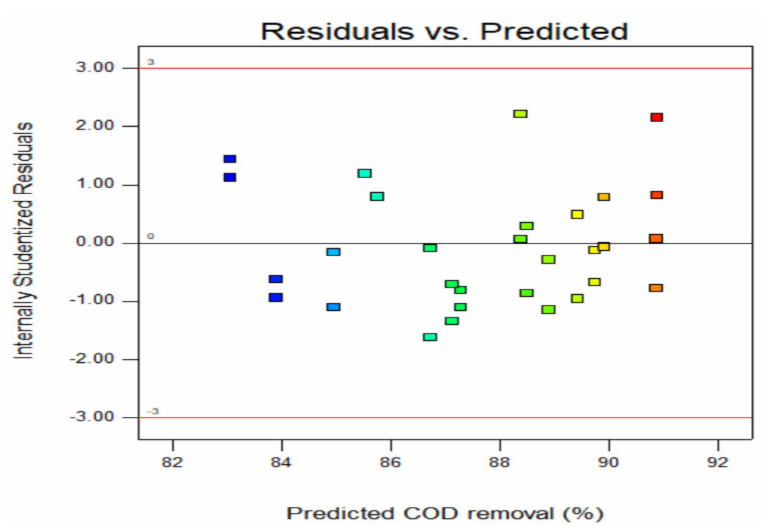
Figure 4. The plot of internally studentized residuals vs. predicted response.